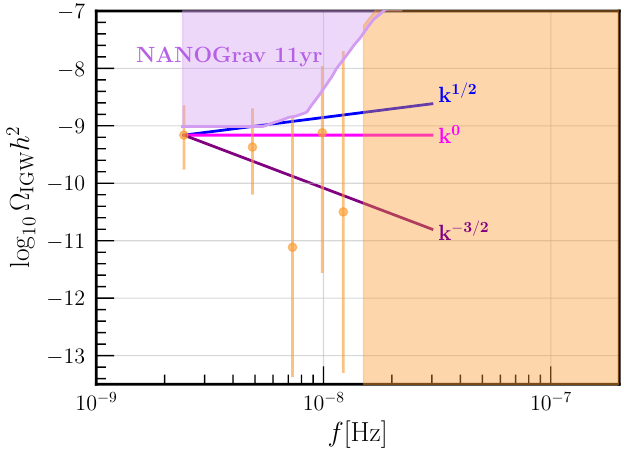
Figure 9. NANOGrav results on the possible SGWB [18] in terms of spectral density. The orange dots are the data points from the timing residuals with their error bars. We only show the first five data points which are the most relevant. The points in the orange shaded region were compatible with white noise and not considered for the fit. In light purple we also show the NANOGrav 11-yr sensitivity curve from [327]. In solid lines we show the allowed slopes within the 1- σ contours. In blue and purple we respectively show the upper and lower limits on the slope, k 1/2 and k − 3/2 . In magenta we give the approximate best fit for the data, which is a scale invariant